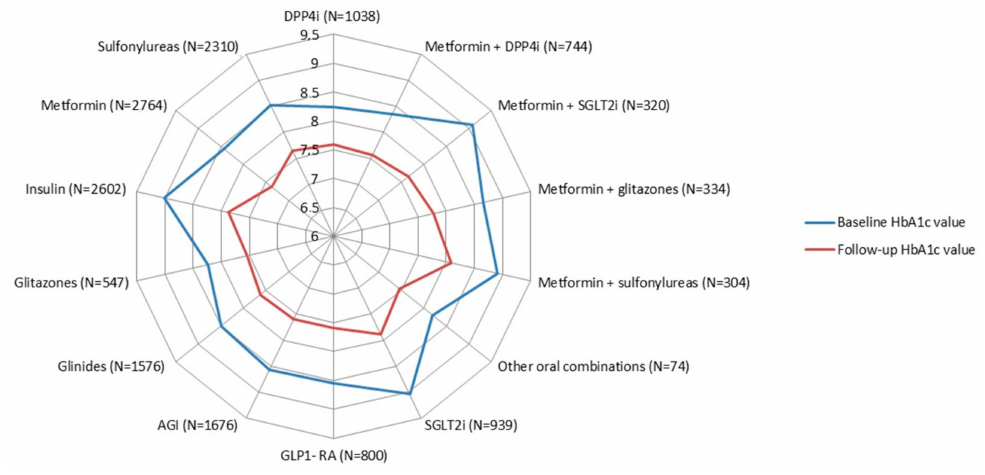
Figure 4. Comparison between the mean HbA1c values (%) at baseline and within six months after ID, stratified by AD molecule / class. Legend: AGI = alpha-glucosidase inhibitors; DPP4i = dipeptidyl peptidase-4 inhibitors; GLP-1RA = glucagon-like peptide-1 receptor antagonists; SGLT2i = sodium–glucose linked transporter 2 inhibitors; Other oral combinations = fixed-dose combinations of glitazones + DPP4i and glitazones + sulfonylureas; ID = index date. In subjects ≤ 70 years old, glycated hemoglobin target value < 7%; in subjects > 70 years old, glycated hemoglobin target value ≤ 8%.